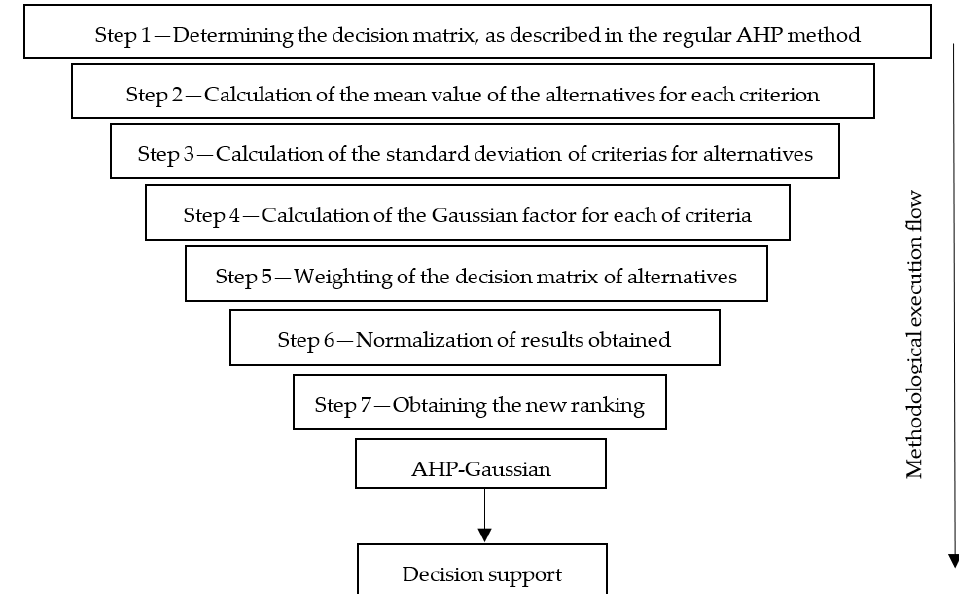
Figure 8. Steps for AHP-Gaussian.